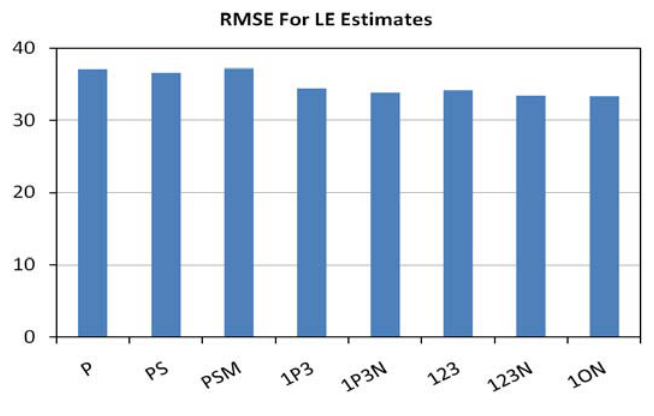
Figure 19. Error rates for estimation of luminous efficacy.